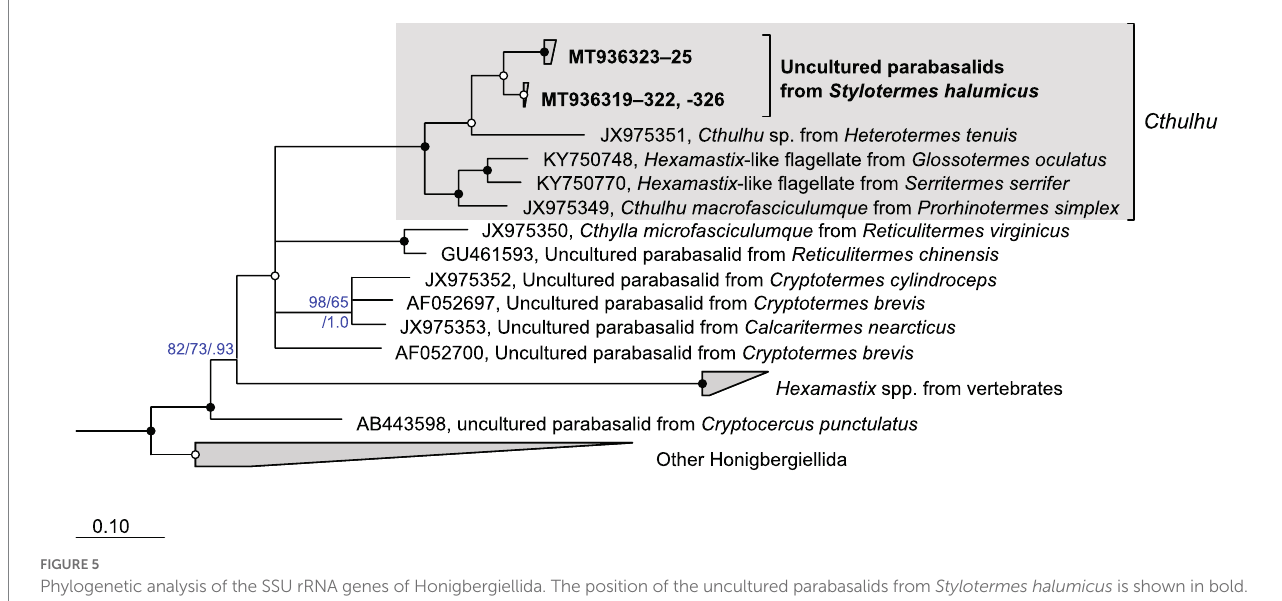
FIGURE 5 Phylogenetic analysis of the SSU rRNA genes of Honigbergiellida. The position of the uncultured parabasalids from Stylotermes halumicus is shown in bold. The maximum-likelihood tree was reconstructed with IQ-TREE using members of Trichomonadida as outgroup. Tree topology was tested with PhyML and Bayesian analysis (Ba); conflicting nodes are shown as multifurcation. Bullets indicate high node support in all analyses: SH-aLRT/ultrafast bootstrap/ posterior probabilities ≥ 96/99/1.00 (•), ≥ 80/95/0.98 (•); in other cases, individual values are shown. Collapsed clades are labeled with the number of sequences